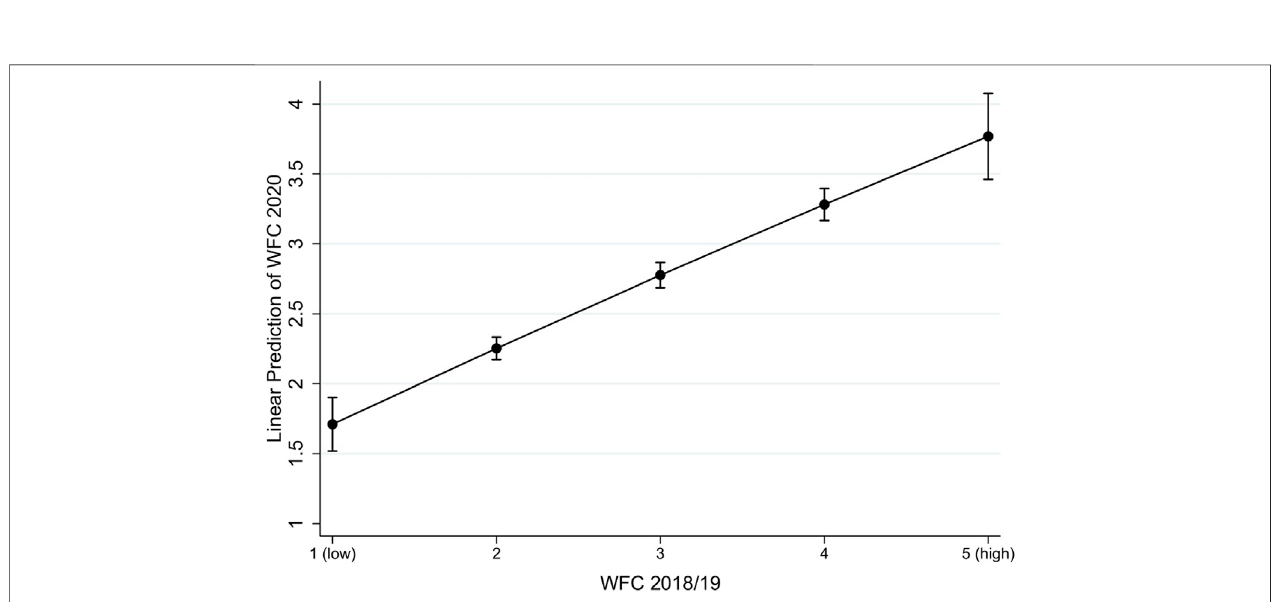
Frontiers in Sociology |